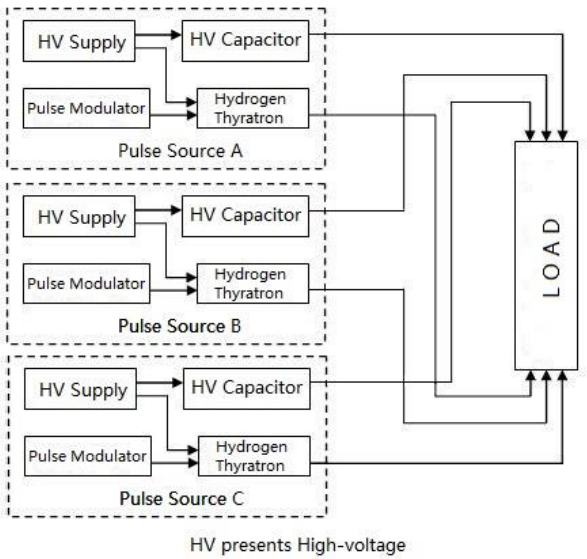
Figure 3. Realization method of high-repetition rate electromagnetic pulse.